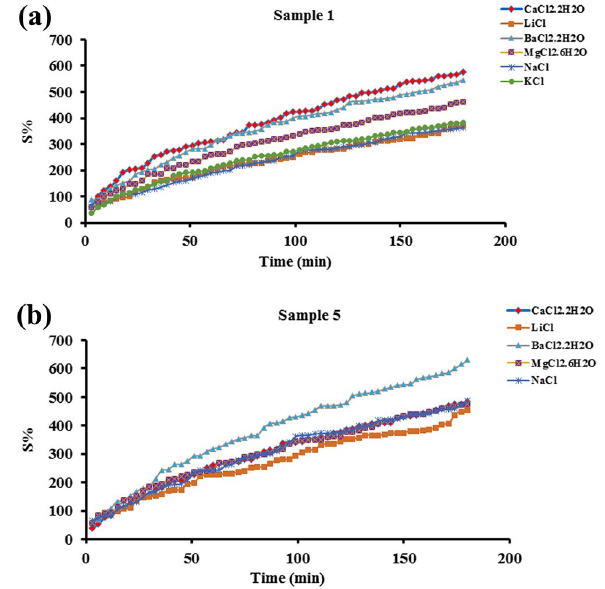
Fig. 7 Swelling changes in samples 1 (a) and 5 (b) in all salt solutions over